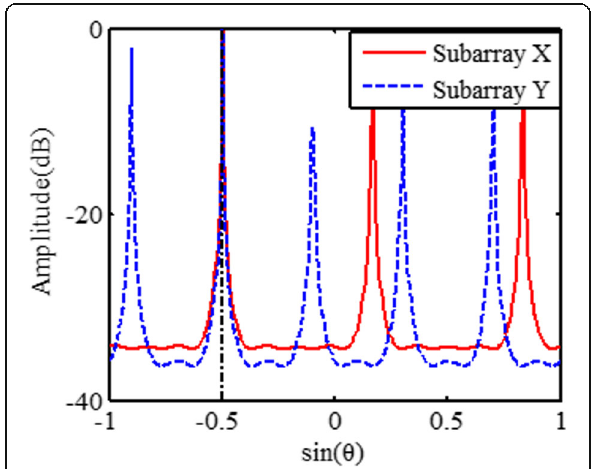
Fig. 5 MUSIC spectral of the decomposed two uniform linear arrays. The picture shows MUSIC spectrums with M = 5 and N = 3 are shown for the case of only one sine